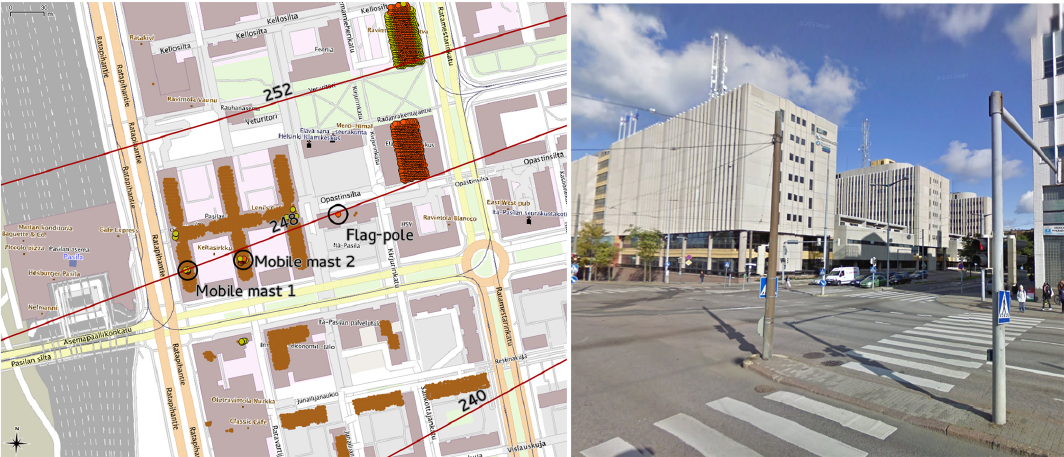
Figure 9. Left: Itä-Pasila partial beam blockage. Lines show beam center path for 252, 248 and 240 ◦ azimuths; dots are ALS data, and colors correspond to altitude above sea level (brown: 60m; yellow: 65m; orange: 70m; red 75m; and purple: > 75m). The two masts and a flagpole along the beam path are also reported. Right: Google Street View of the two masts from Böle bro (Itä-Pasila, Helsinki. Map. Google Street View. Google, June 2009. Web. 3 February